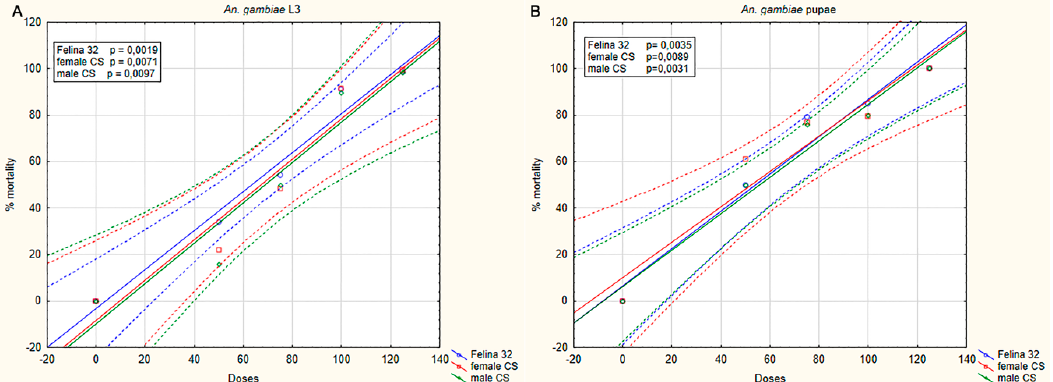
Figure 3. Dose–response curve of insecticidal activity of C. sativa essential oils (EOs) on An. gambiae preadults. Larvae ( A ) and pupae ( B ) were exposed for 24 h to different dilutions of EOs (50, 75, 100, and 125 ppm). The level of susceptibility of both larvae and pupae to the EOs was found to be statistically significant (as reported in figure). EO samples, Felina 32 inflorescence; CS female inflorescence; CS male inflorescence.